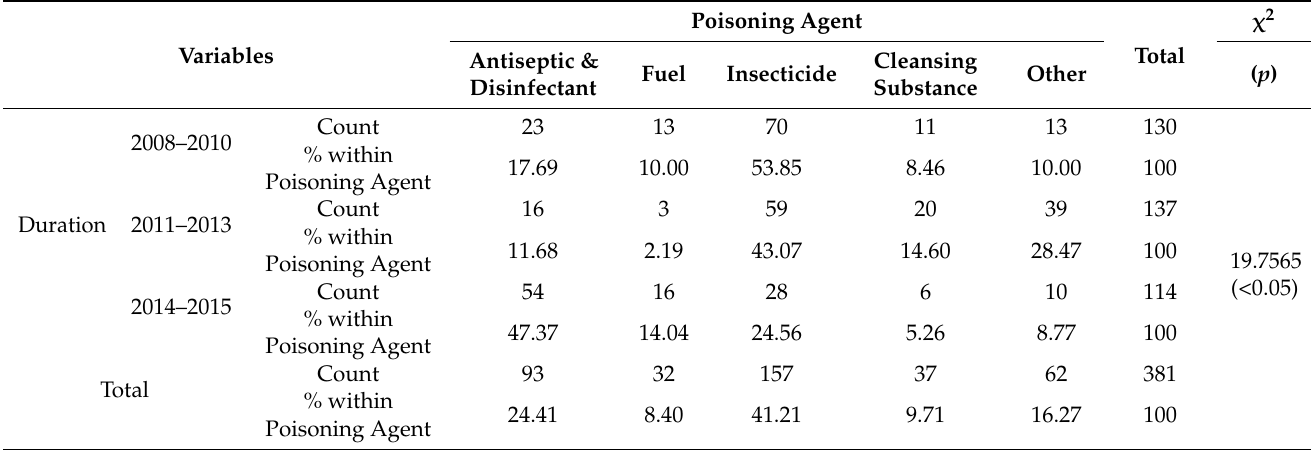
Table 3. Relationship between time period and frequency and type of poison